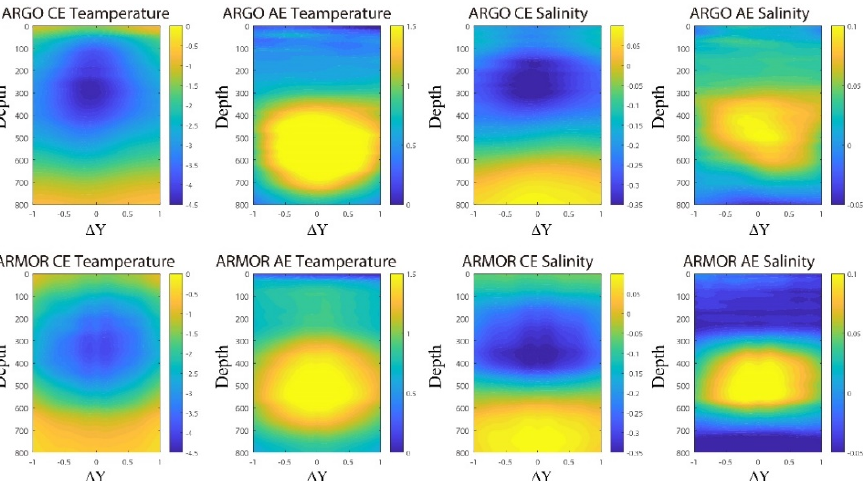
Figure 15. Temperature and salt anomaly distribution of ARMOR 3D and Argo composite eddy in vertical section at Δ X = 0 (First row: ARGO; Second row: ARMOR 3D). The horizontal axis label is the normalized radius at zonal direction, and the vertical axis label is the depth.